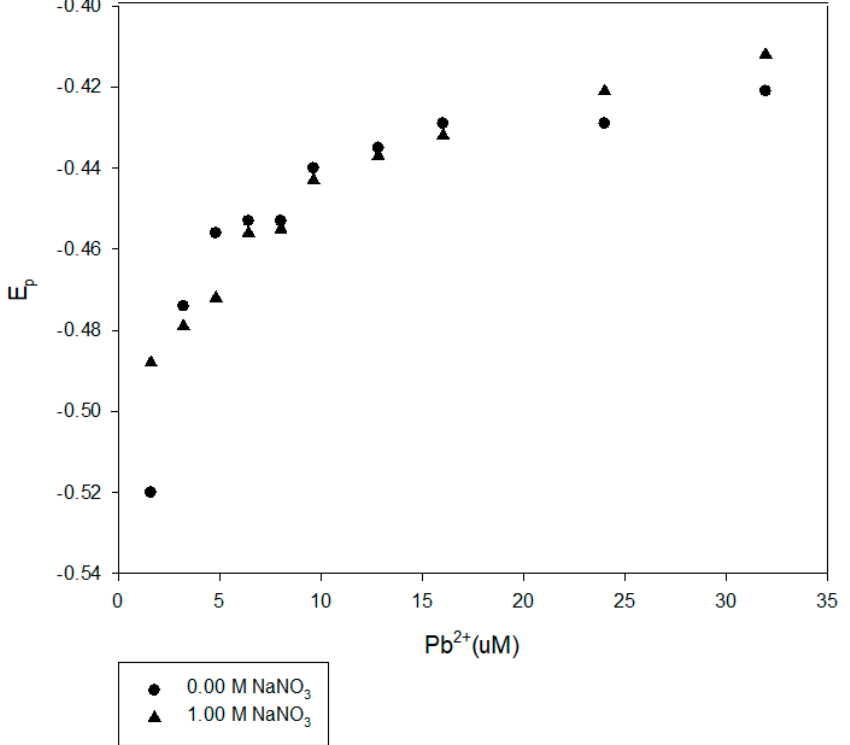
Figure 11. Comparison of DPP results for Pb 2+ at pH 8 in the presence of 100-mg/L International Humic Substances Society (IHSS) leonardite humic acid with and without 1.00-M NaNO 3 .